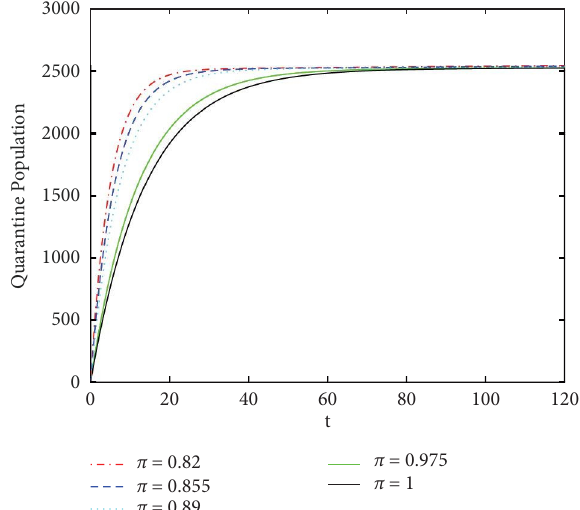
Figure 11: Te dynamics of quarantine human population for various fractional orders υ and for fractal order π � 0 .